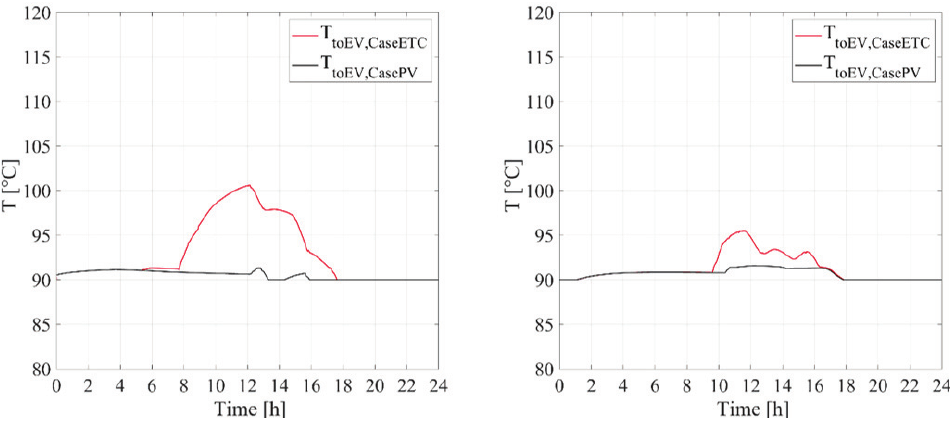
Figure 5. Feeding temperature of the evaporator of ORC: a typical summer day ( left ) and a typical winter day ( right